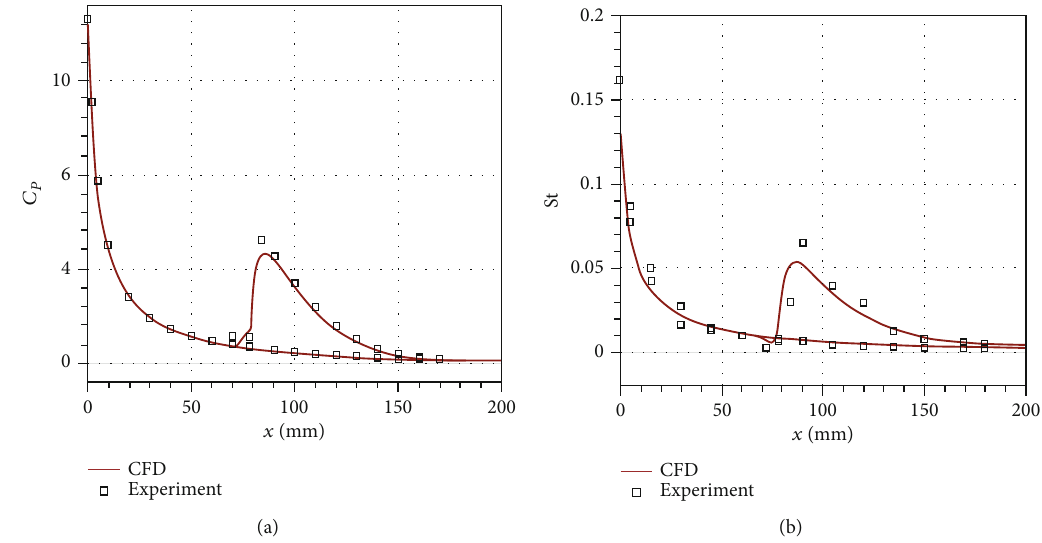
results from VC1; (b) St results from VC2. P